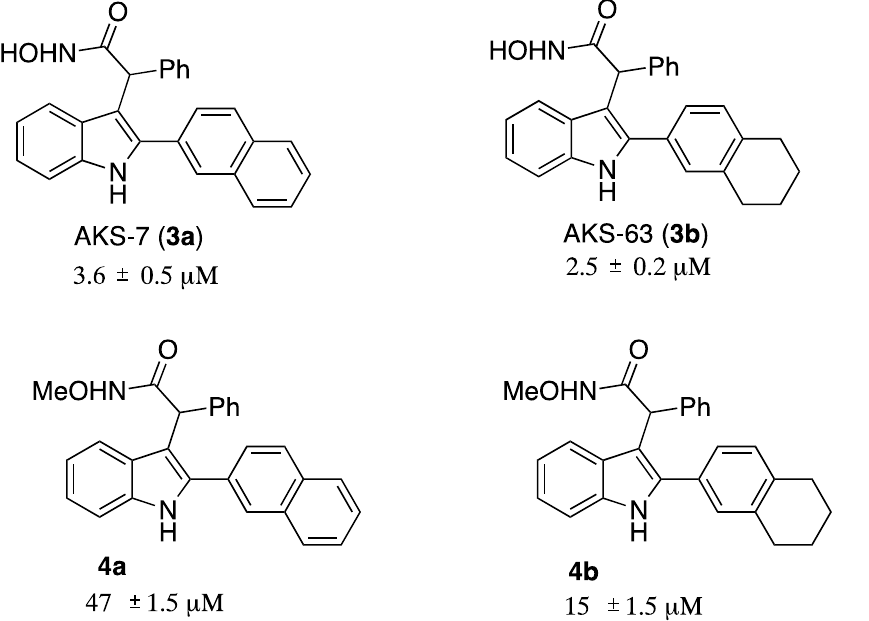
Figure 1. Antiproliferative activity (IC 50 ) of the synthesized compounds against HeLa cervical ade- nocarcinoma.